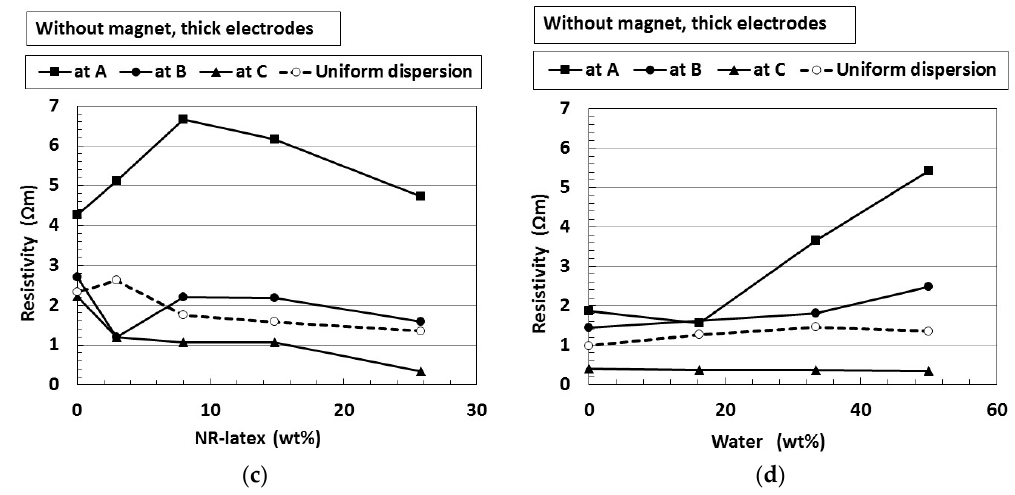
Figure 5. Resistivity to changes in each component of MCF rubber liquid in the case without a magnet and using thick electrodes in “A”, “B”, and “C” in Figure 2b and uniform dispersion: ( a ) Ni; ( b ) Fe 3 O 4 ; ( c ) NR-latex; ( d ) water.